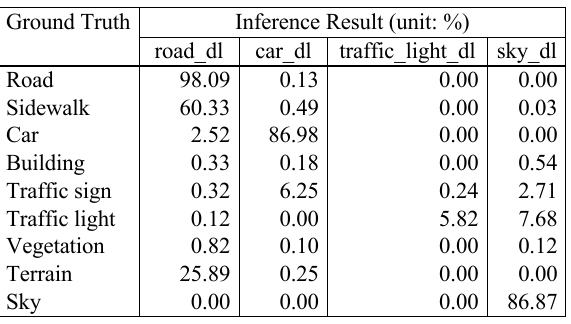
Table 3 . RFIP for the selected pairs of landscape elements.